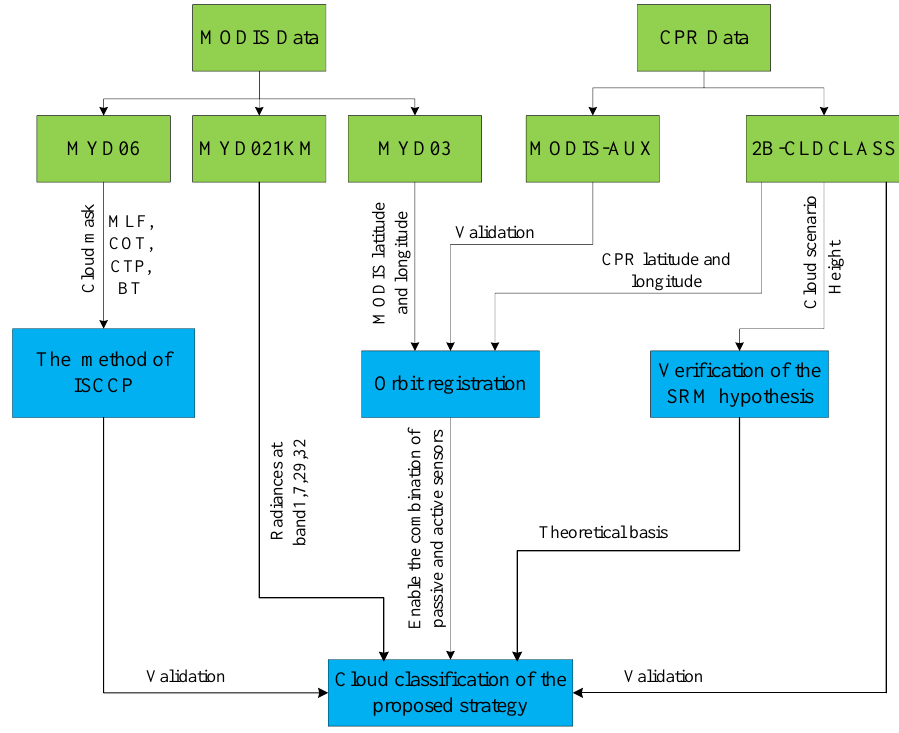
Figure 1. Concept diagram of the proposed strategy.